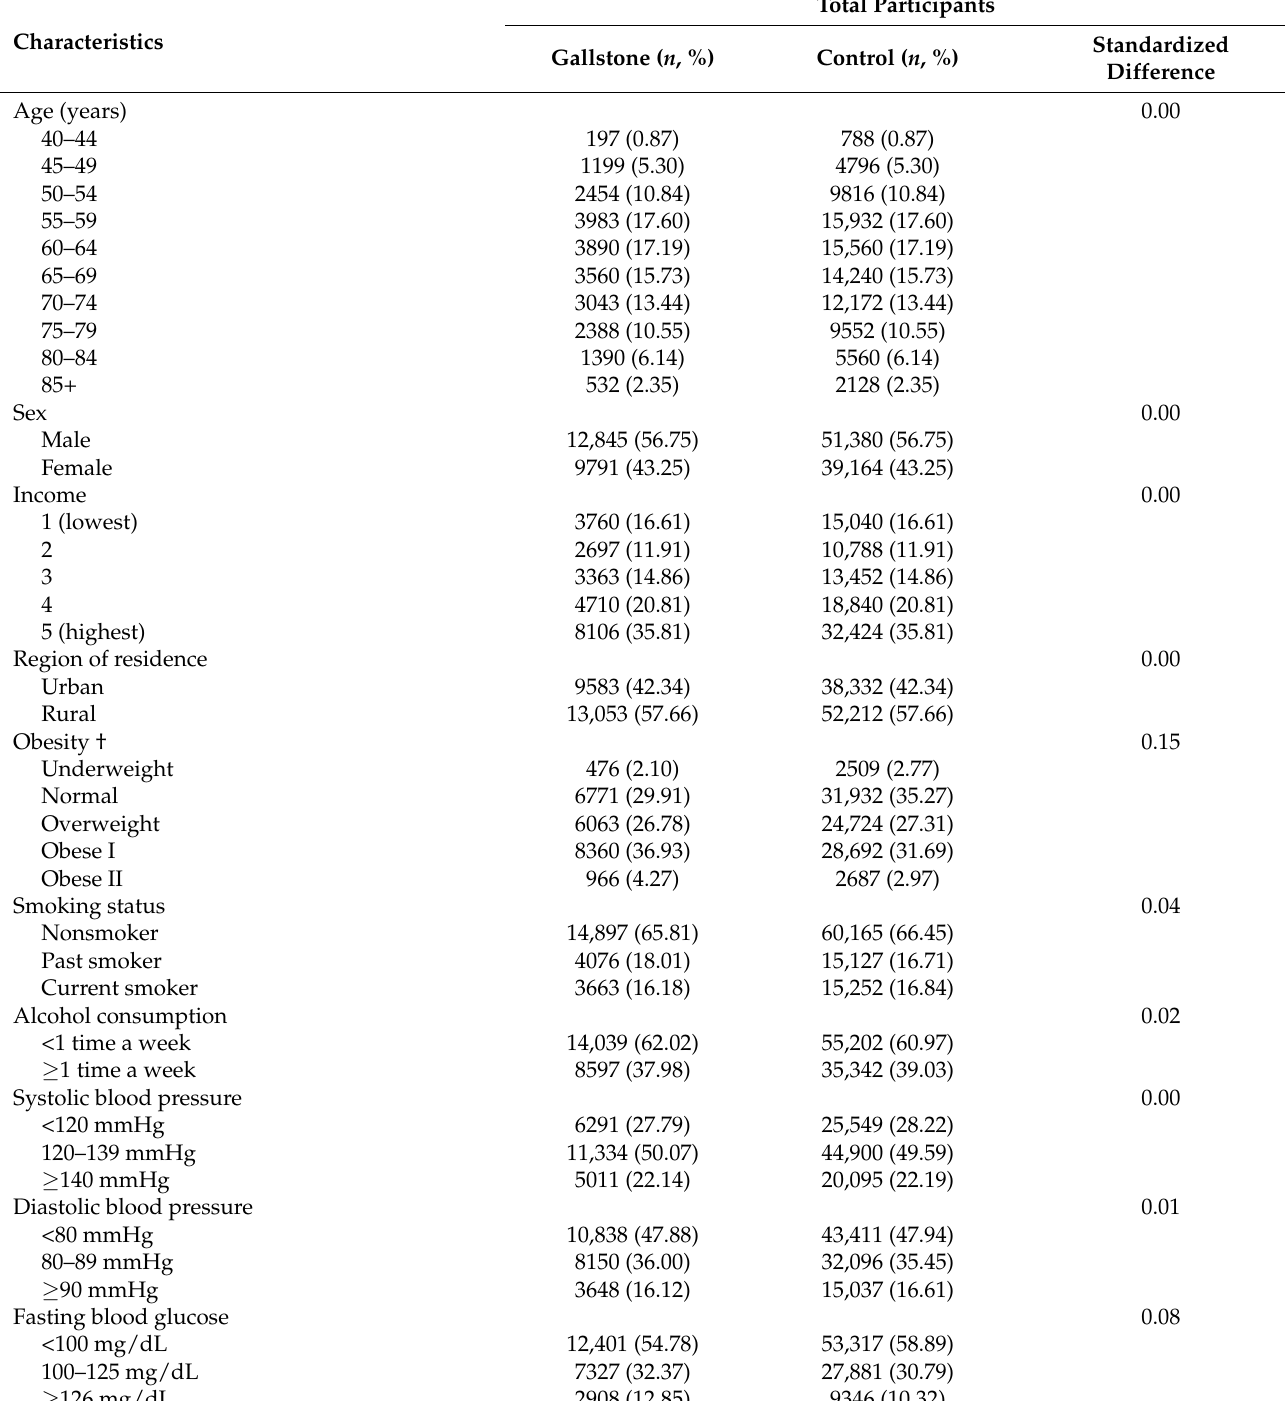
Table 1. General characteristics of